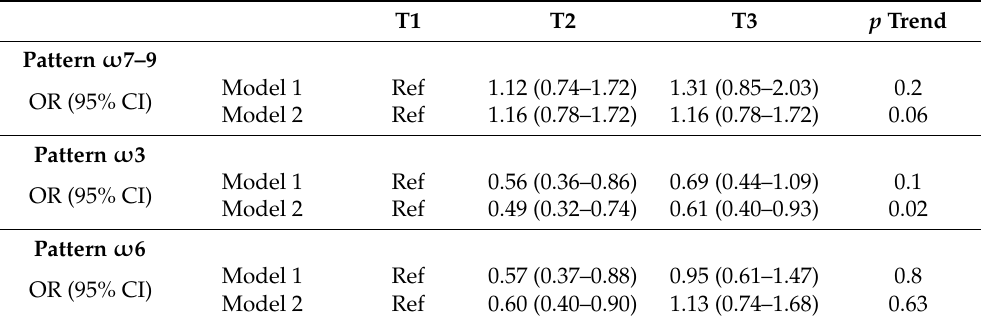
Table 4. Multivariate analysis of the association between FA patterns and baseline high disease activity (DAS28 ≥ 5.1) ( n =